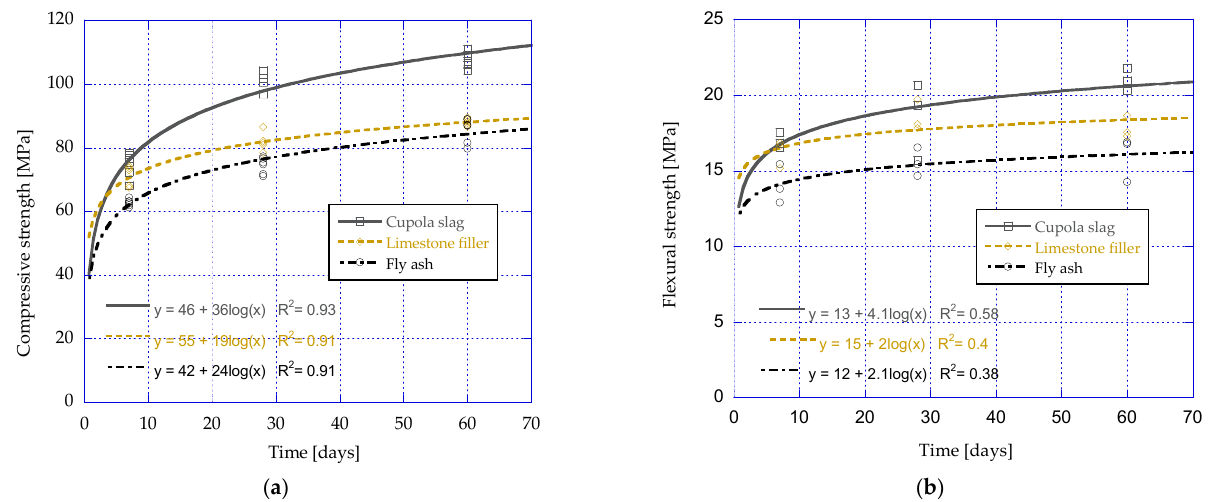
Figure 8. Mechanical properties of mortars with different admixtures: compressive strength ( a ); flexural strength ( b ).